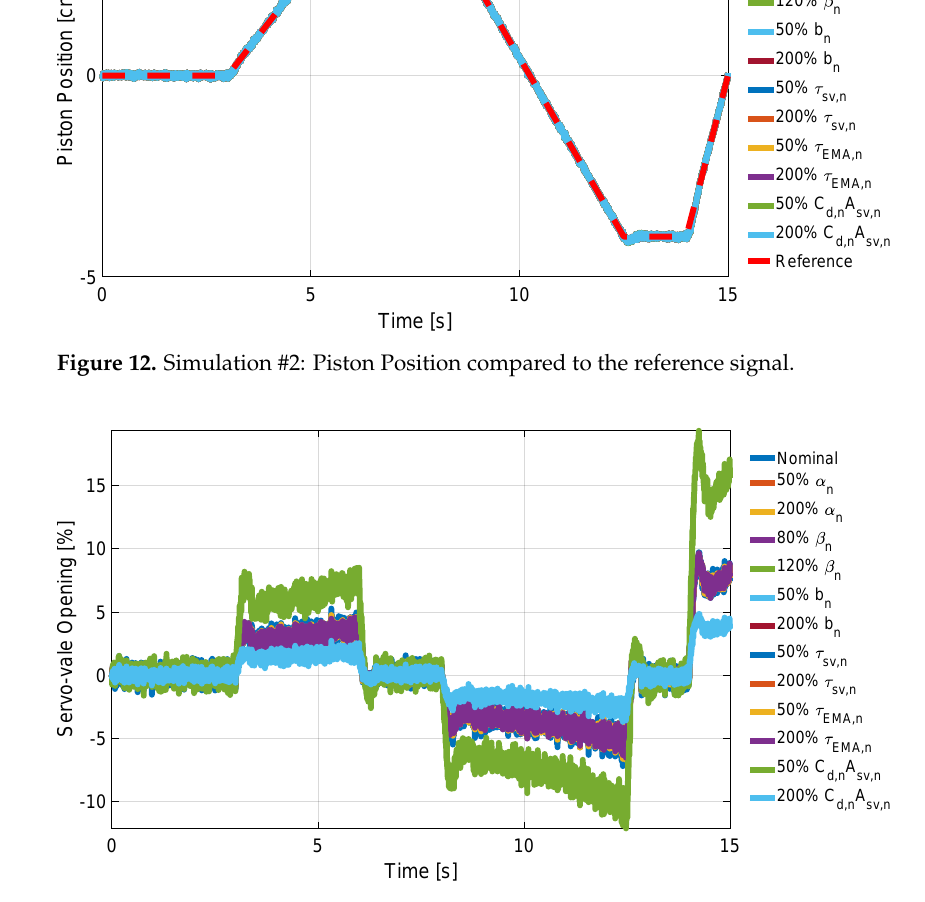
Figure 13. Simulation #2: Servo-valve opening